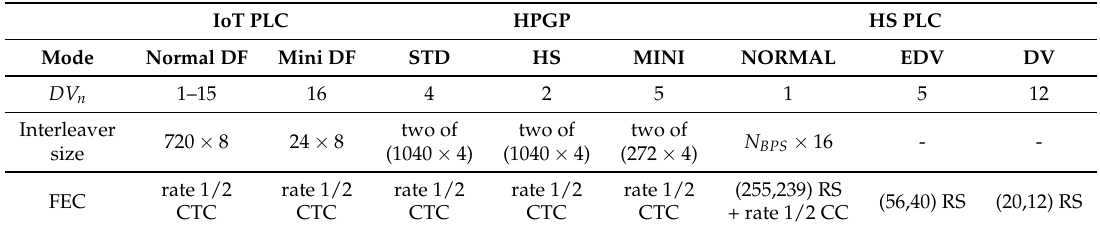
Table 1. Operation modes and data protection